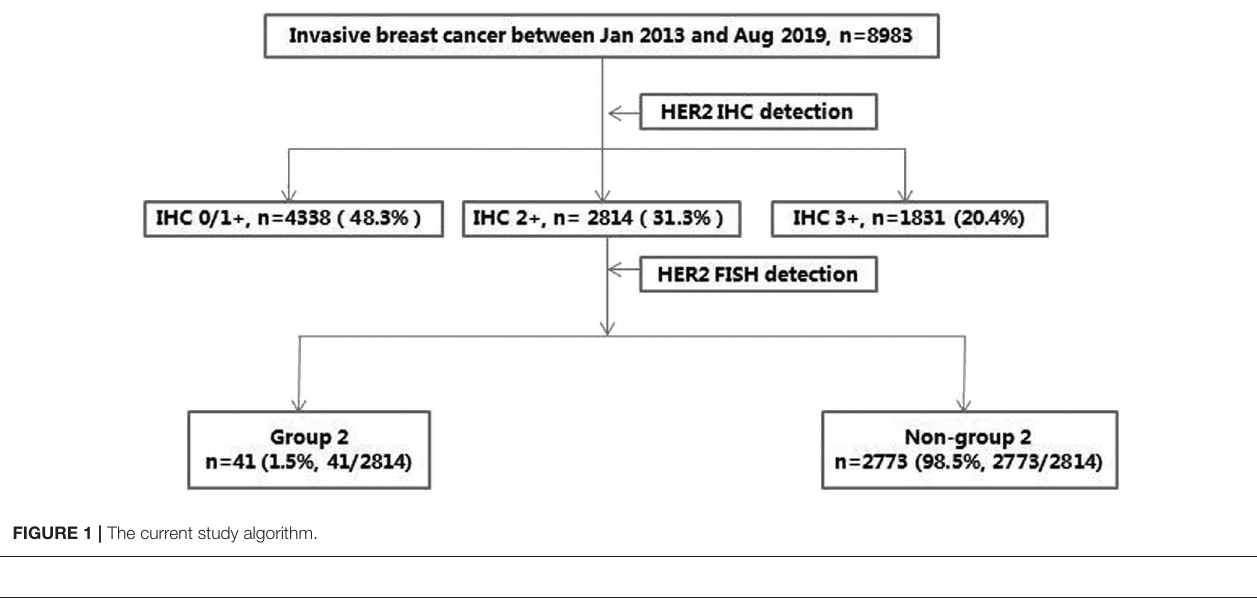
FIGURE 1 | The current study algorithm.